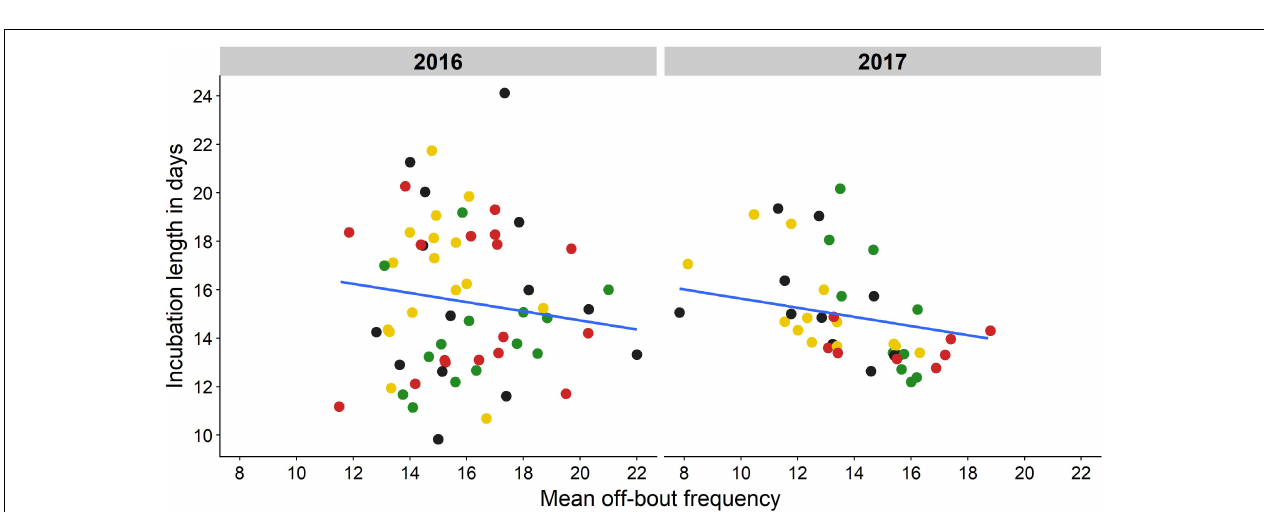
FIGURE 4 | Mean off-bout duration in early and late incubation. Raw means for off-bout duration in minutes ± SE are depicted for each treatment. In the breeding season of 2016, females in the green light treatment had significantly shorter off-bouts compared to the red treatment (top left panel; estimate = − 6.52 min, t.ratio = − 3.43, P = 0.02). While this effect disappeared in late incubation in 2016, it became more pronounced in 2017 (bottom right panel). Specifically, in late incubation females had significantly shorter off-bouts in the green treatment compared to the white treatment (estimate = − 2.63 min, t.ratio = − 3.65, P = 0.009). * P < 0.05.